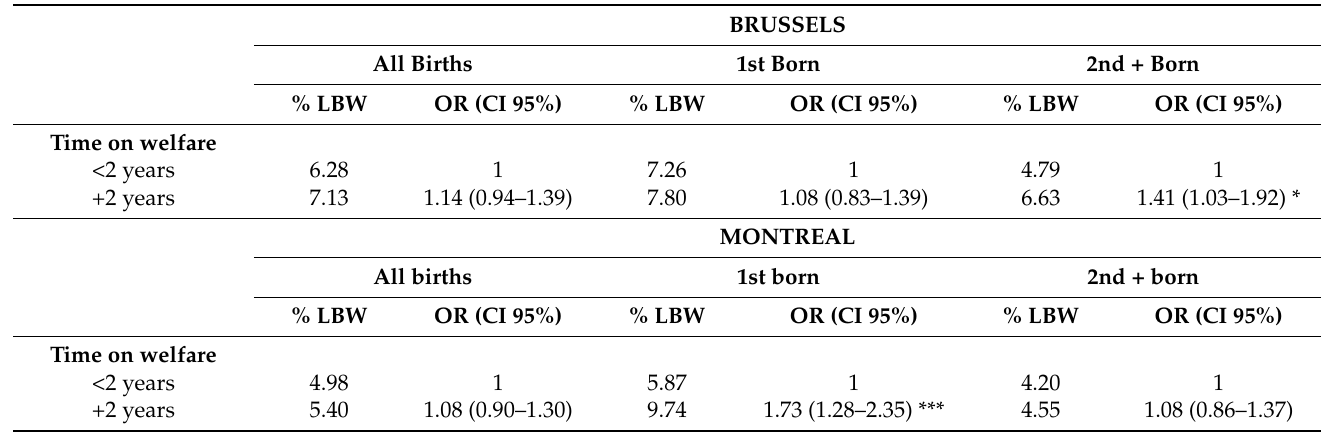
Table 6. Association between LBW and mother’s time on